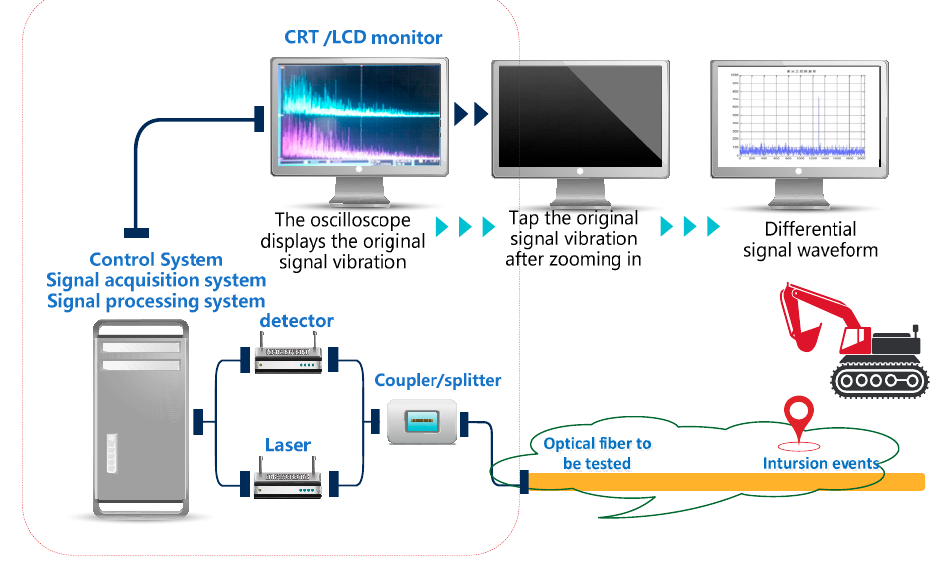
Figure 7. Optical fiber Pre-warning monitoring system.